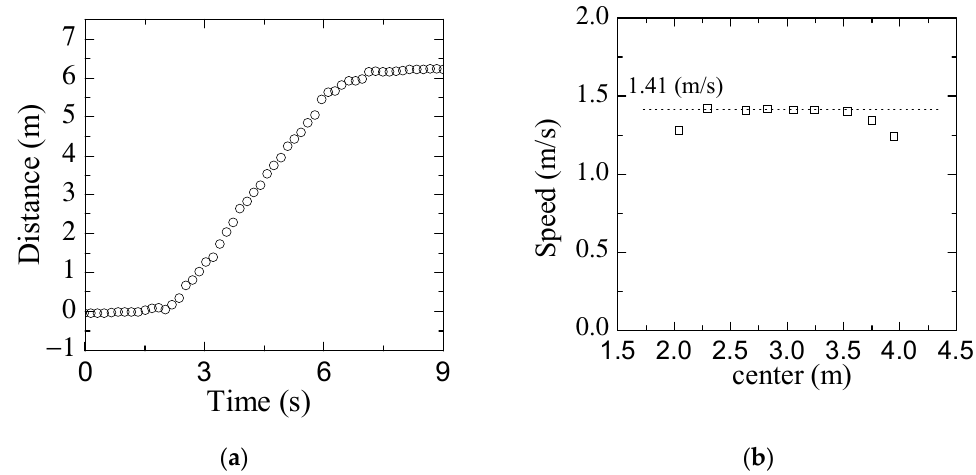
Figure 6. Typical result obtained during a walking-speed test, consisting of the estimated distance of the test subject over time ( a ). Estimated average speed over a 4 m segment of the path vs. the center position of the path ( b ). Apart from the leftmost and rightmost points, that include the starting and stopping phases of the walking process, quite consistent results can be obtained.